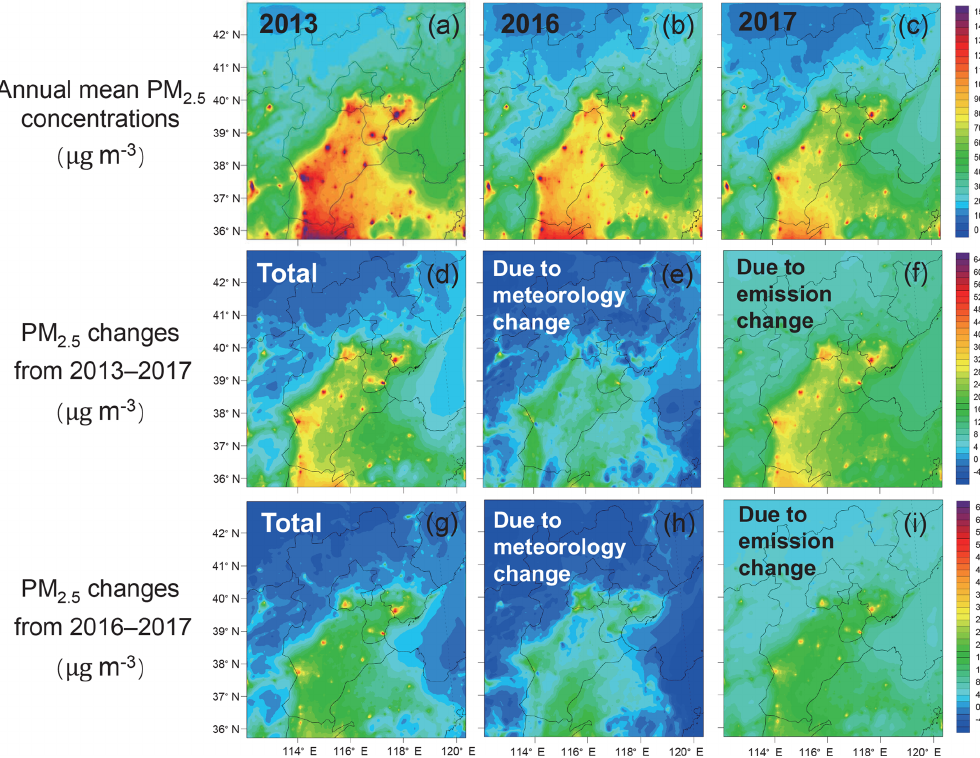
Figure 7. Changes in CMAQ-simulated annual mean PM 2 . 5 concentrations. (a–c) Base simulations of 2013, 2016, and 2017; (d–f) total PM 2 . 5 changes and the changes attributed to meteorology and emission variations during 2013–2017; (g–i) total PM 2 . 5 changes and the changes attributed to meteorology and emission variations during